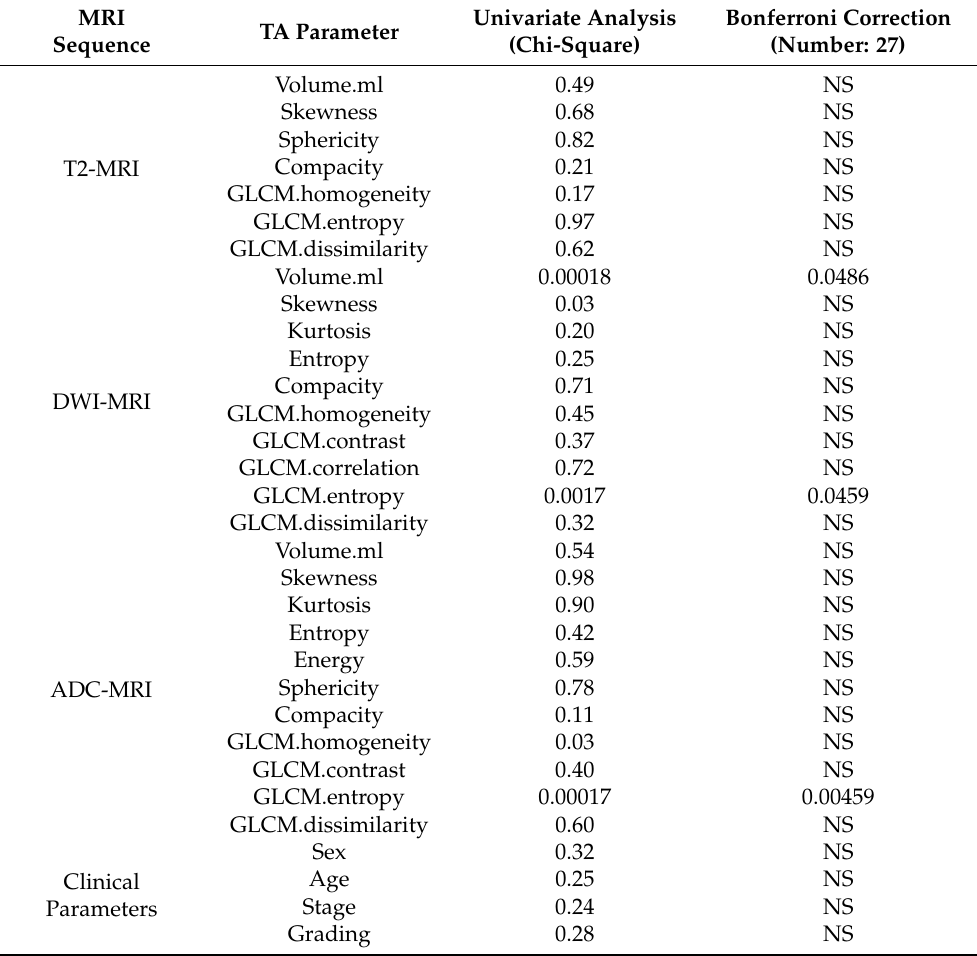
Table 3. Univariate analysis (Chi-Square) of the reliable texture features and the chosen endpoint (TRG0) for the training